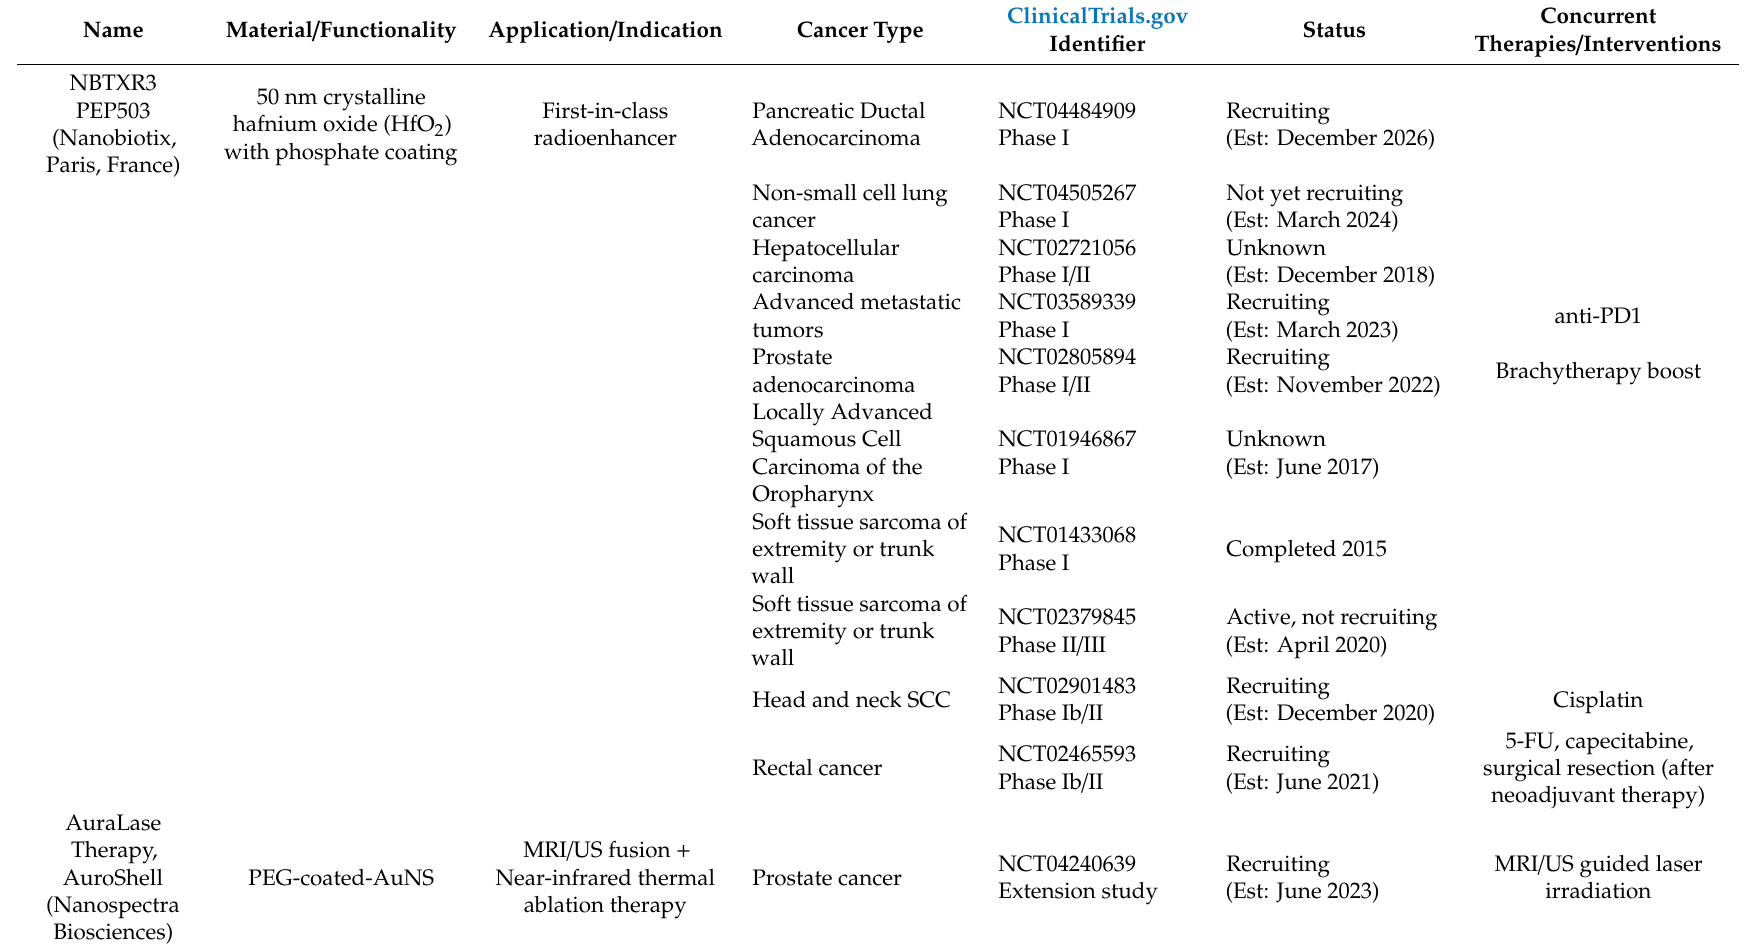
Table 2. Inorganic nanoparticles undergoing clinical